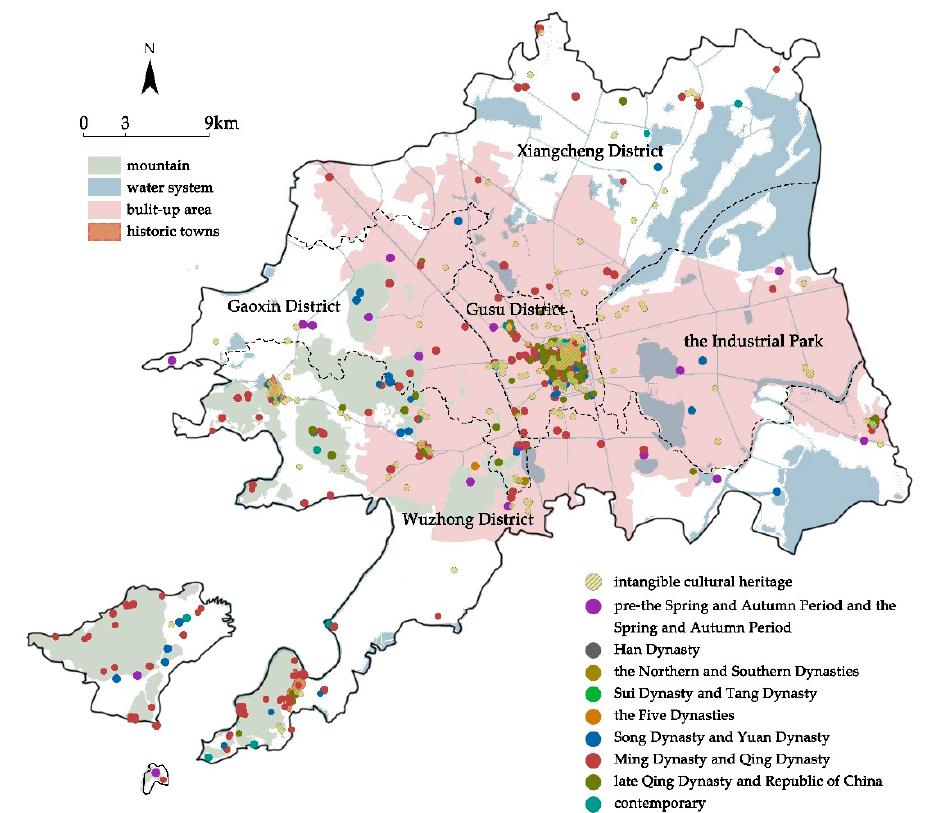
Figure 11. Distribution of heritages in Suzhou.